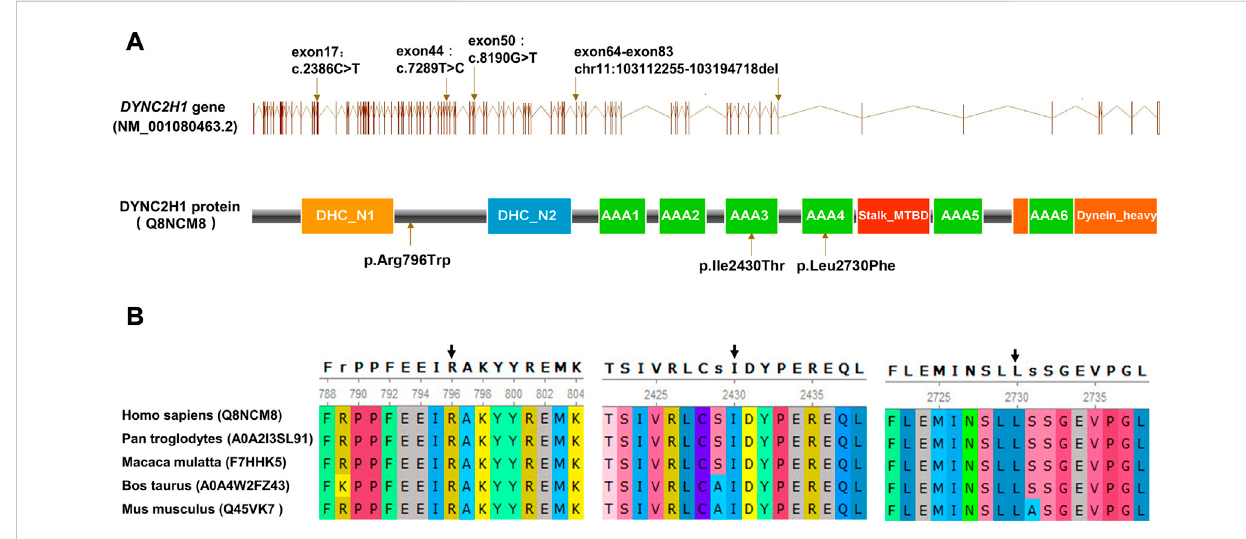
FIGURE 3 (A) Schematic diagram of the DYNC2H1 protein and the locations of the variants detected. (B) Conservation analysis of DYNC2H1 indicated that the protein at position 796, 2430 and 2730 are highly conserved in various species.